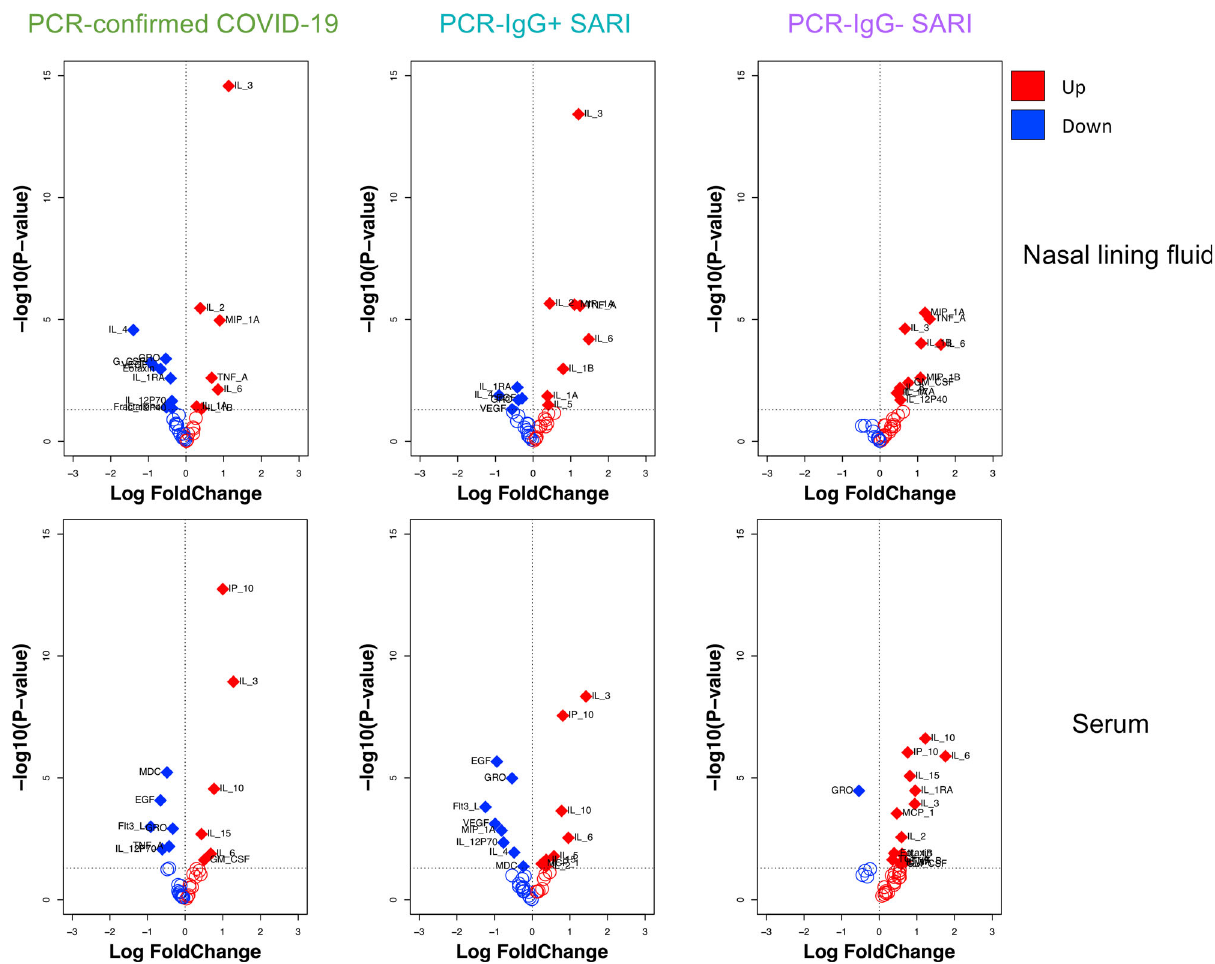
Fig. 2 Cytokine concentrations in nasal lining fl uid and serum. Volcano plots showing differential cytokine concentrations in nasal lining fl uid and serum of PCR-con fi rmed COVID-19, PCR − /IgG + SARI and PCR − /IgG − SARI patients compared to health controls. The horizontal dotted line represents a cut-off for statistical signi fi cance, while the vertical dotted line represents a cut-off point for determining whether the levels of the cytokines were higher (right, red) or lower (left, blue) compared to healthy controls. Data were analysed using empirical Bayes moderated two-sided t -tests and adjusted p values are reported (healthy controls, n = 25; PCR-con fi rmed COVID-19, n = 25; PCR − /IgG + SARI, n = 16; PCR − /IgG − SARI, n = 11). SARS-CoV-2 severe acute respiratory syndrome coronavirus 2, COVID-19 coronavirus disease of 2019, PCR polymerase chain reaction, IgG immunoglobulin G, SARI severe acute respiratory infection. Source data are provided as a Source Data fi